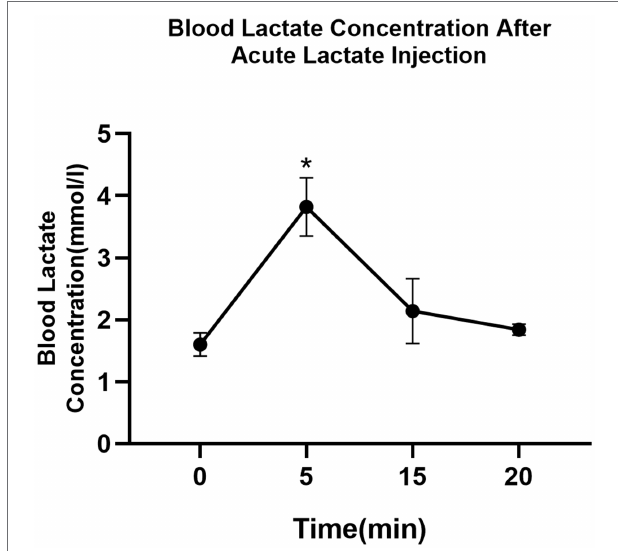
FIGURE 2 | The time-dependent effects of intramuscular lactate-injection on blood lactate level. The blood lactate was determined at rest and 5, 10, 15, and 20 min after the injection. The data are presented as the mean ± SD, and significant differences between two groups were analyzed with the independent-samples t -test. * p < 0.05 vs. 0